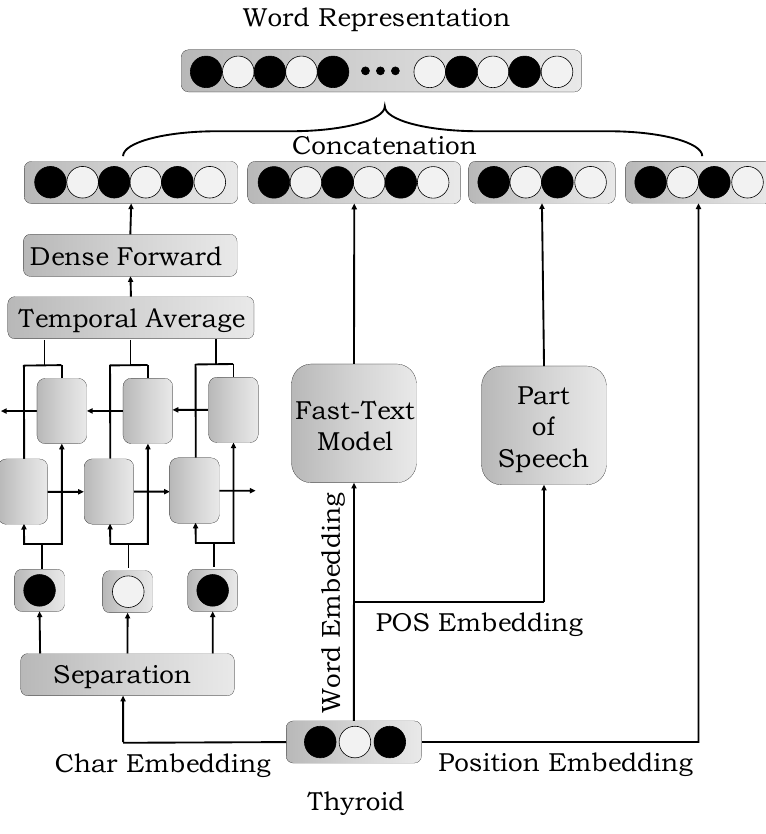
Figure 2. The extraction module of the word representation. The one on the far left is character embedding; the middle one is word embedding; and the two on the right are part of speech embedding and position